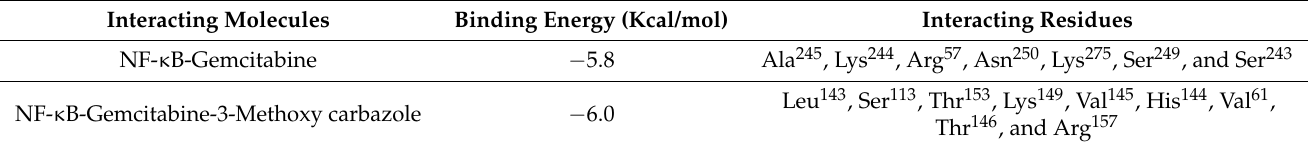
Figure 1. Three-dimensional chemical structures of ( A ) 3-Methoxy carbazole, ( B ) Gemcitabine and ( C ) NF- κ B.